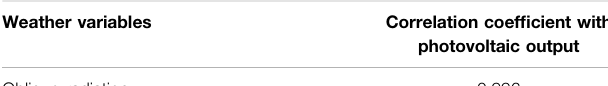
TABLE 1 | Results of DCC. Weather